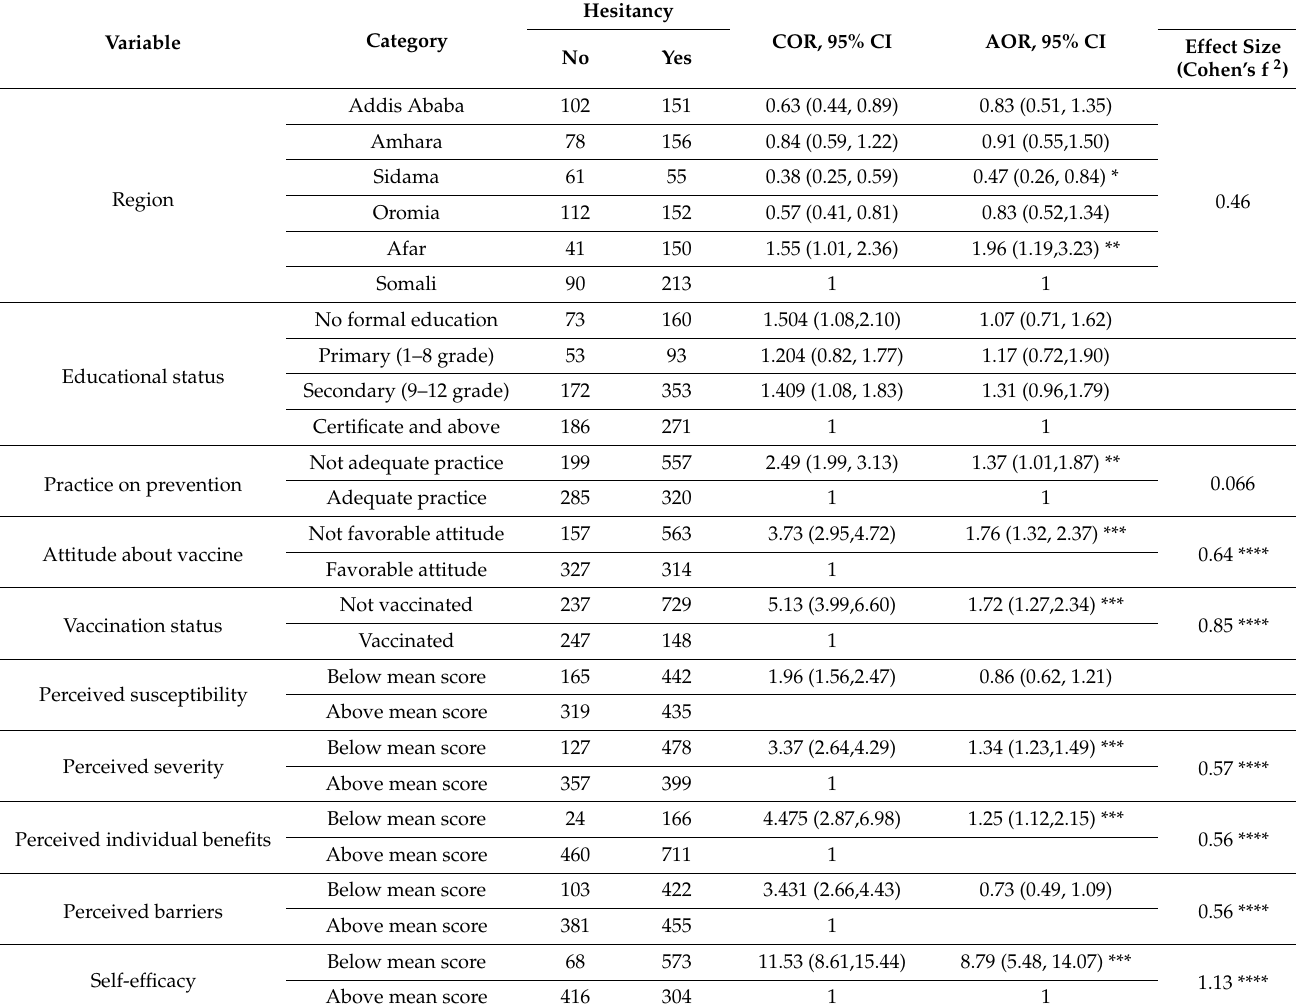
Table 10. Multivariable binary logistic regression results from the COVID-19 vaccine hesitancy survey, Ethiopia,